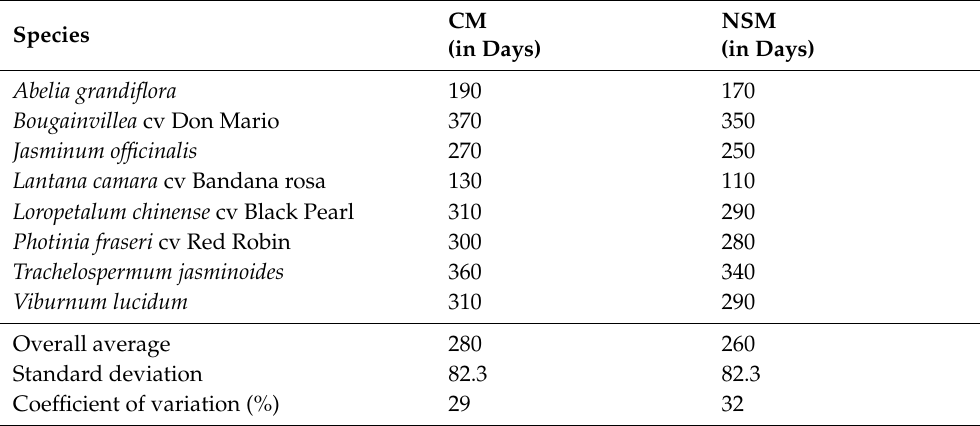
Table 6. Ornamental species life span (in days) associated with two production models: conventional production model (CM) and novel and sustainable production model (NSM) among 8 selected ornamental species.